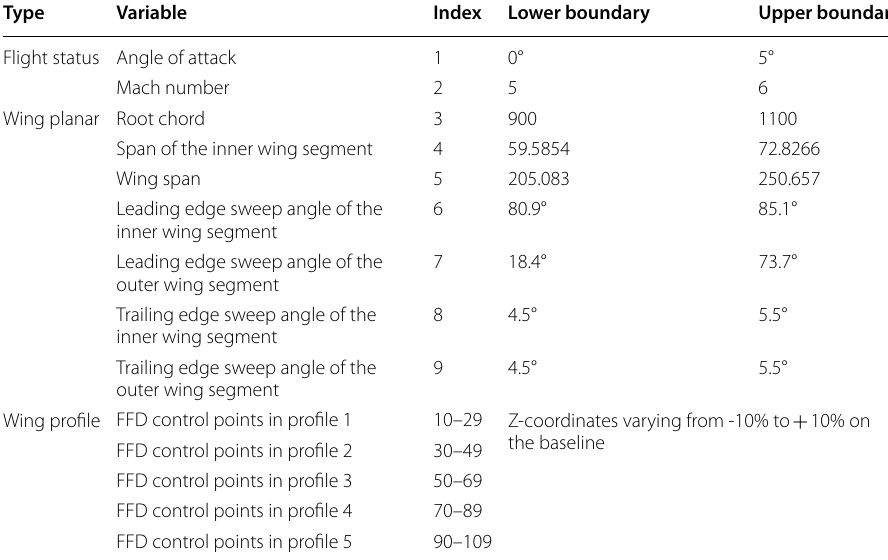
Table 2 Upper and lower boundaries of the input variables for the CNN Type